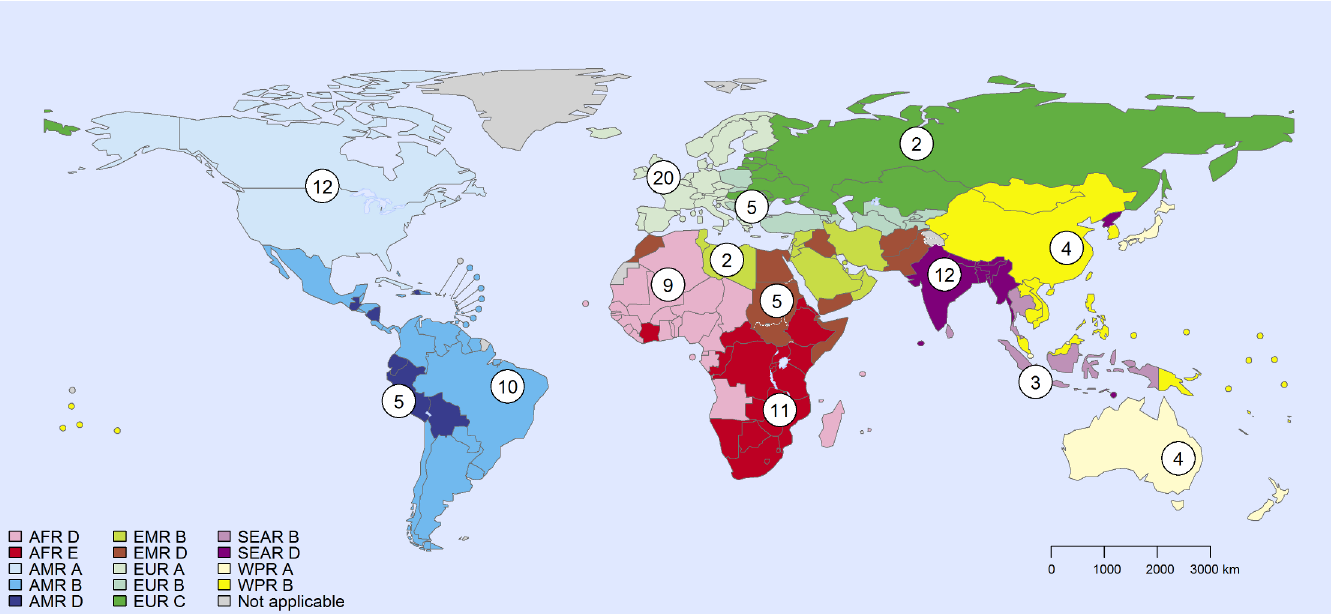
Fig 1. Global subregions and number of expert panelists with more than 3 yearsof work experience in the subregion. Subregions are definedon the basis of child and adult mortality as describedby Ezzati et al. (2002) [18]. Stratum A: very low child and adult mortality; Stratum B: low child mortality and very low adult mortality; Stratum C: low child mortality and high adult mortality; Stratum D: high child and adult mortality; and Stratum E: high child mortality and very high adult mortality. AFR = Africa Region;AMR = Regionof the Americas; EMR = Eastern Mediterranean Region;EUR = EuropeanRegion; SEAR = South-East Asia Region; WPR = Western Pacific Region.Havelaaret al. 2015 provides a list of countries in each subregion[1]. The use of the term ‘subregion’here and throughoutthe text does not identify an official groupingof WHO Member States, and the ‘subregions’ are not related to the six official WHO regions [16]. Valuesin circles indicate the numberof experts in panels in each